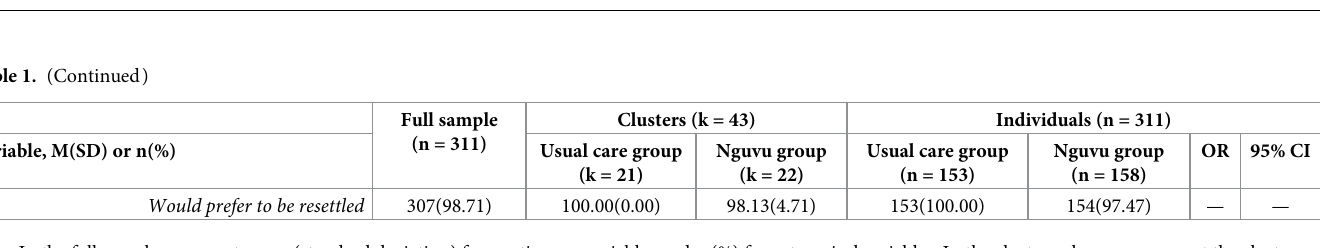
Note: In the full sample we report mean (standard deviation) for continuous variables and n (%) for categorical variables. In the cluster columns, we report the cluster mean (standard deviation) for continuous variables as well as the mean proportion (standard deviation) for categorical variables across clusters. For the individual columns we report the mean (standard deviation) for continuous variables and the n (%) for categorical variables.